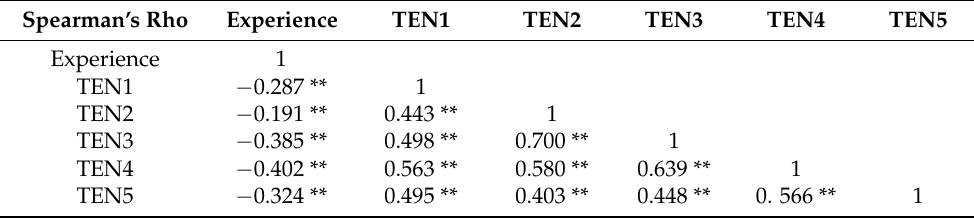
Table 7. Correlation coefficient between the H&S considerations at the tendering stage. Spearman’s